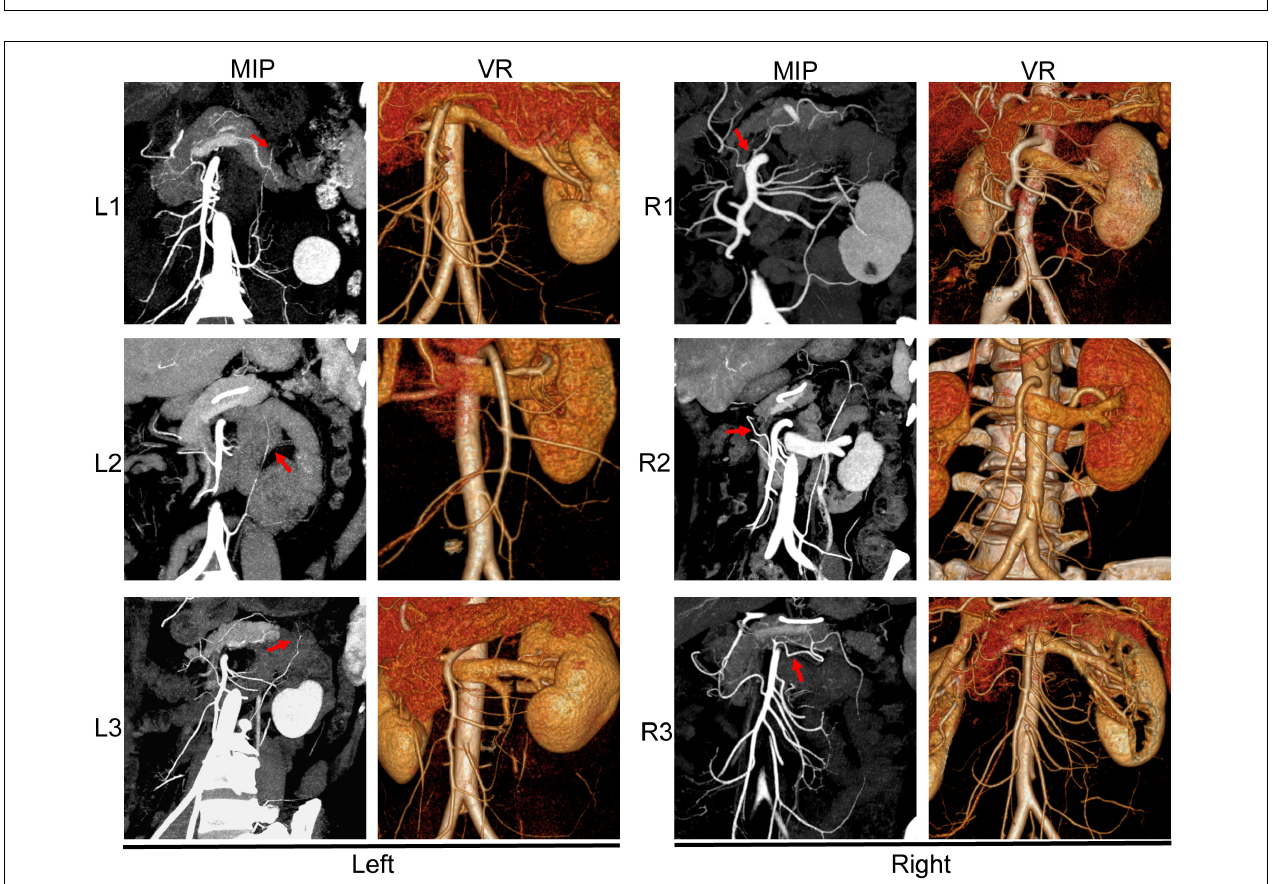
FIGURE 2 | The anatomical patterns of the LCA (left) and MCA (right) .